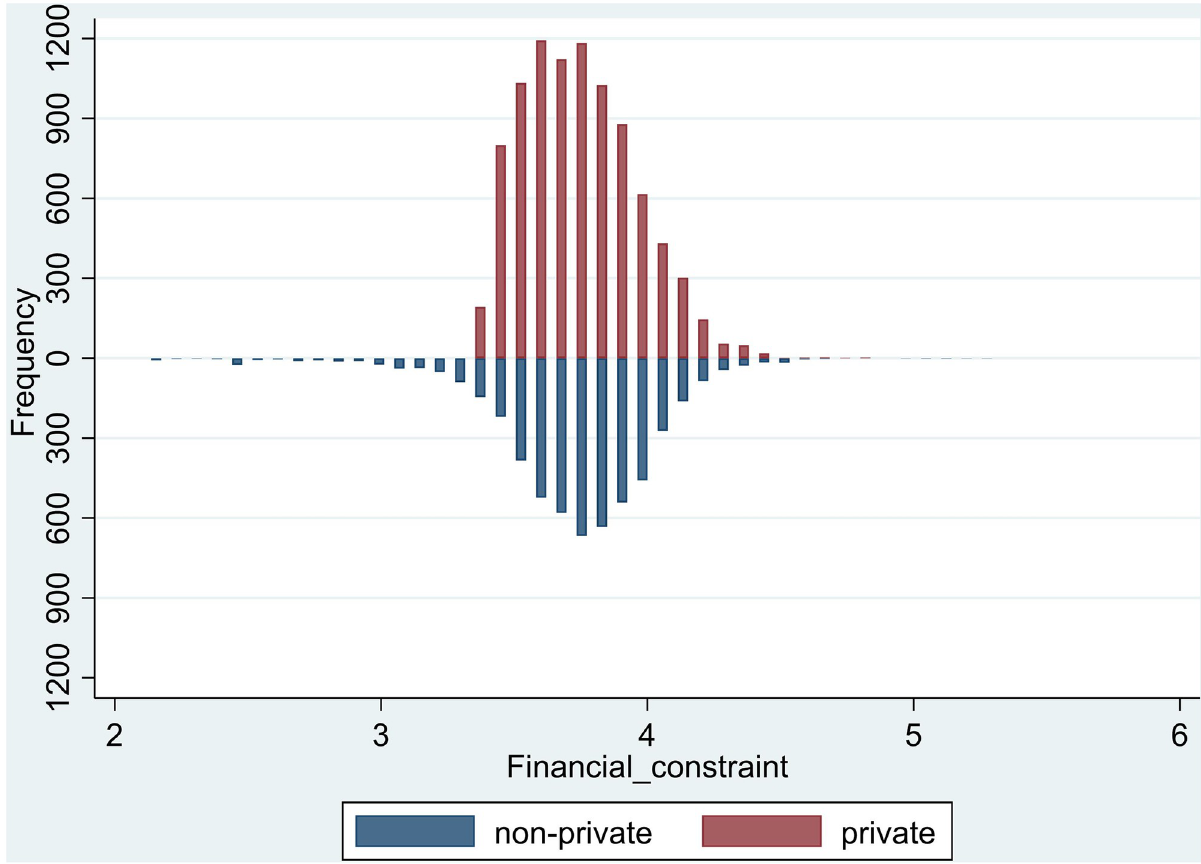
Fig 3. Distribution frequency of financial constraints in private and non-private